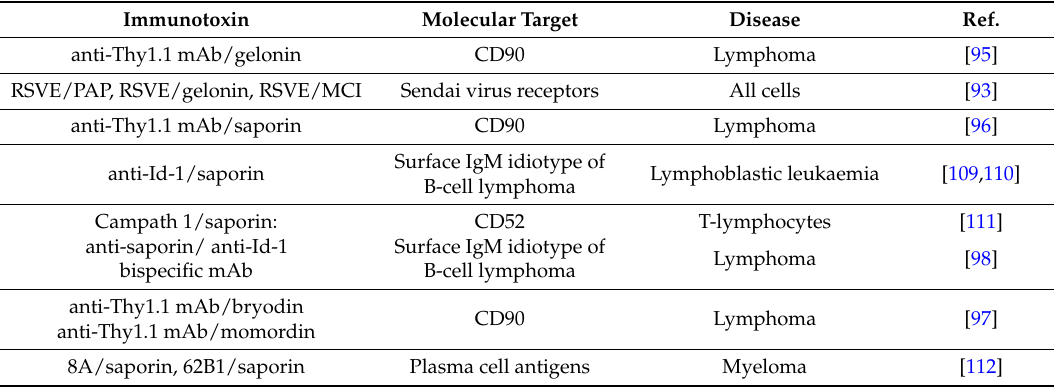
Table 2. Main immunotoxins purified and characterized by Stirpe and